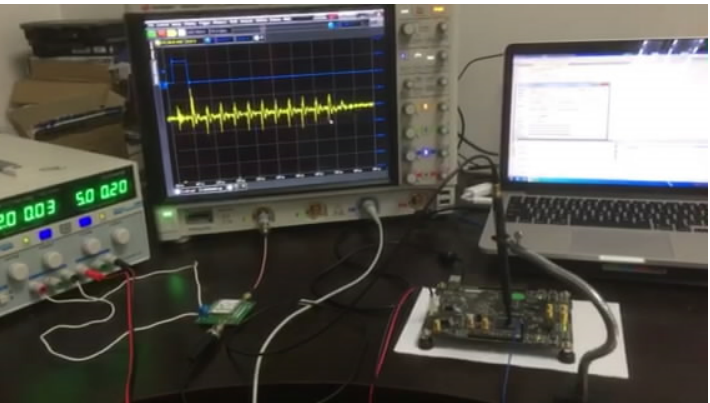
Figure 4. Experimental platform for Particle Swarm Optimization—Correlation Electromagnetic